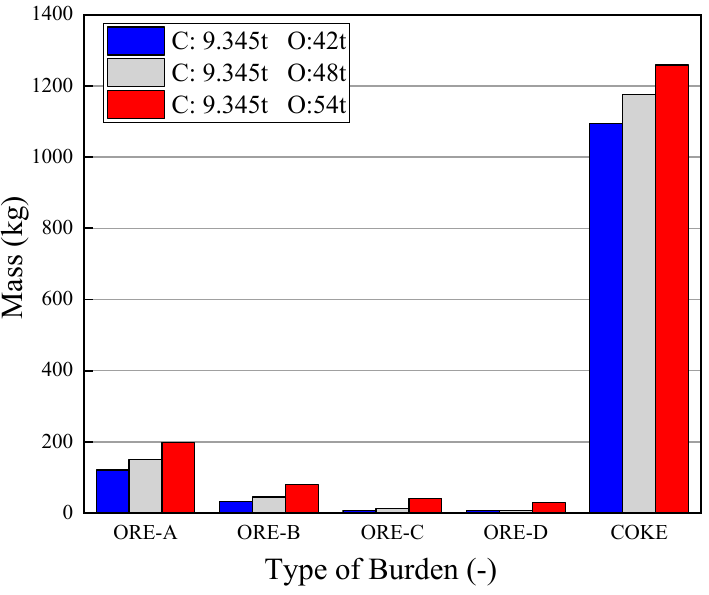
Figure 12. Burden distribution in the sampling area under different ore batch weights.